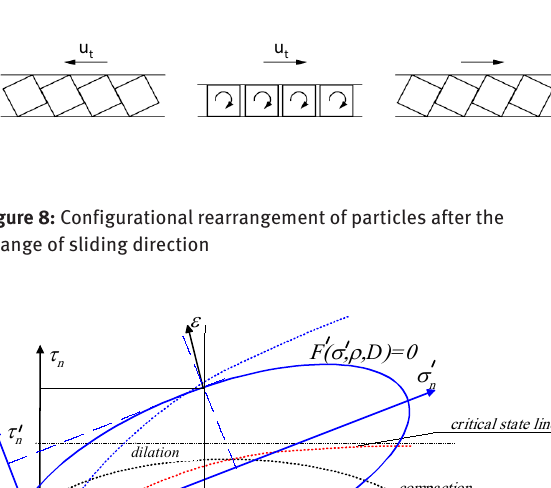
Figure 7: Simulation results for different normal loads ( σ b) variations of dilatancy